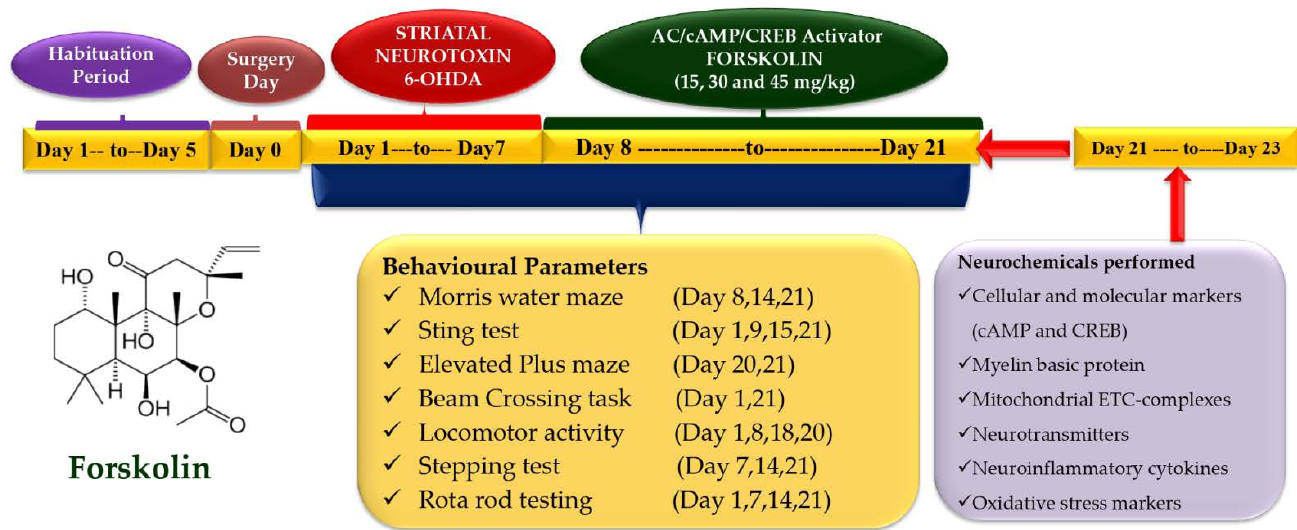
Figure 14. Experimental protocol schedule (behavioural and biochemical estimations).